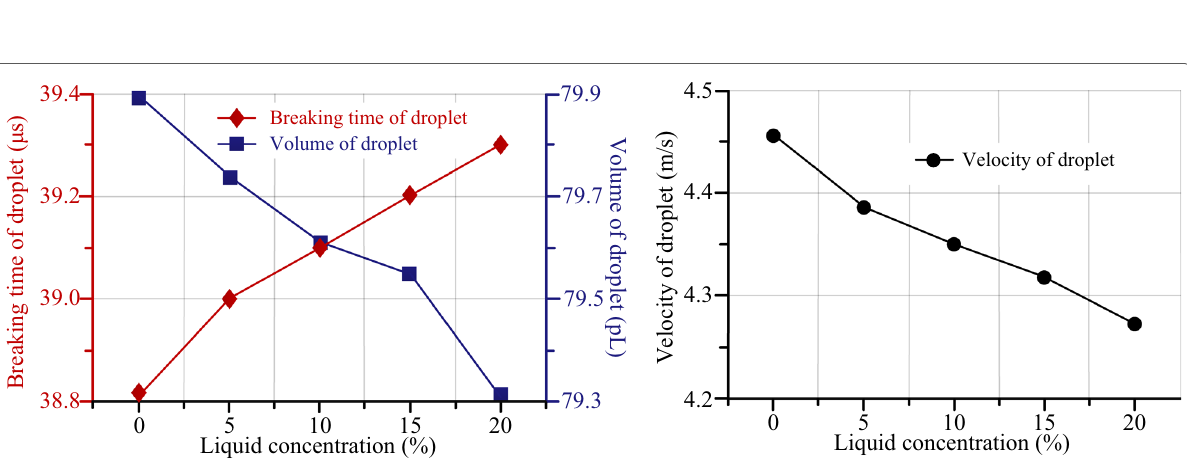
Figure 13 The relationship among breaking time of droplet, volume of droplet, velocity of droplet and liquid